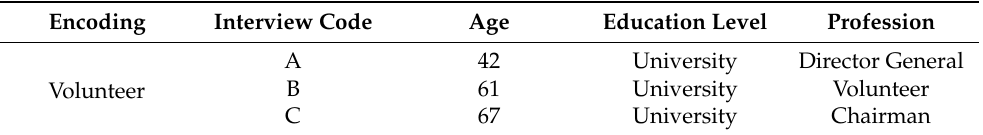
Table 6. Basic information of